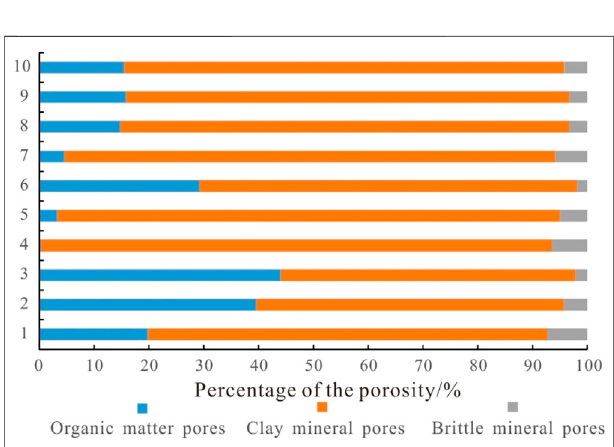
FIGURE 9 | Proportion of pores in Shan 23